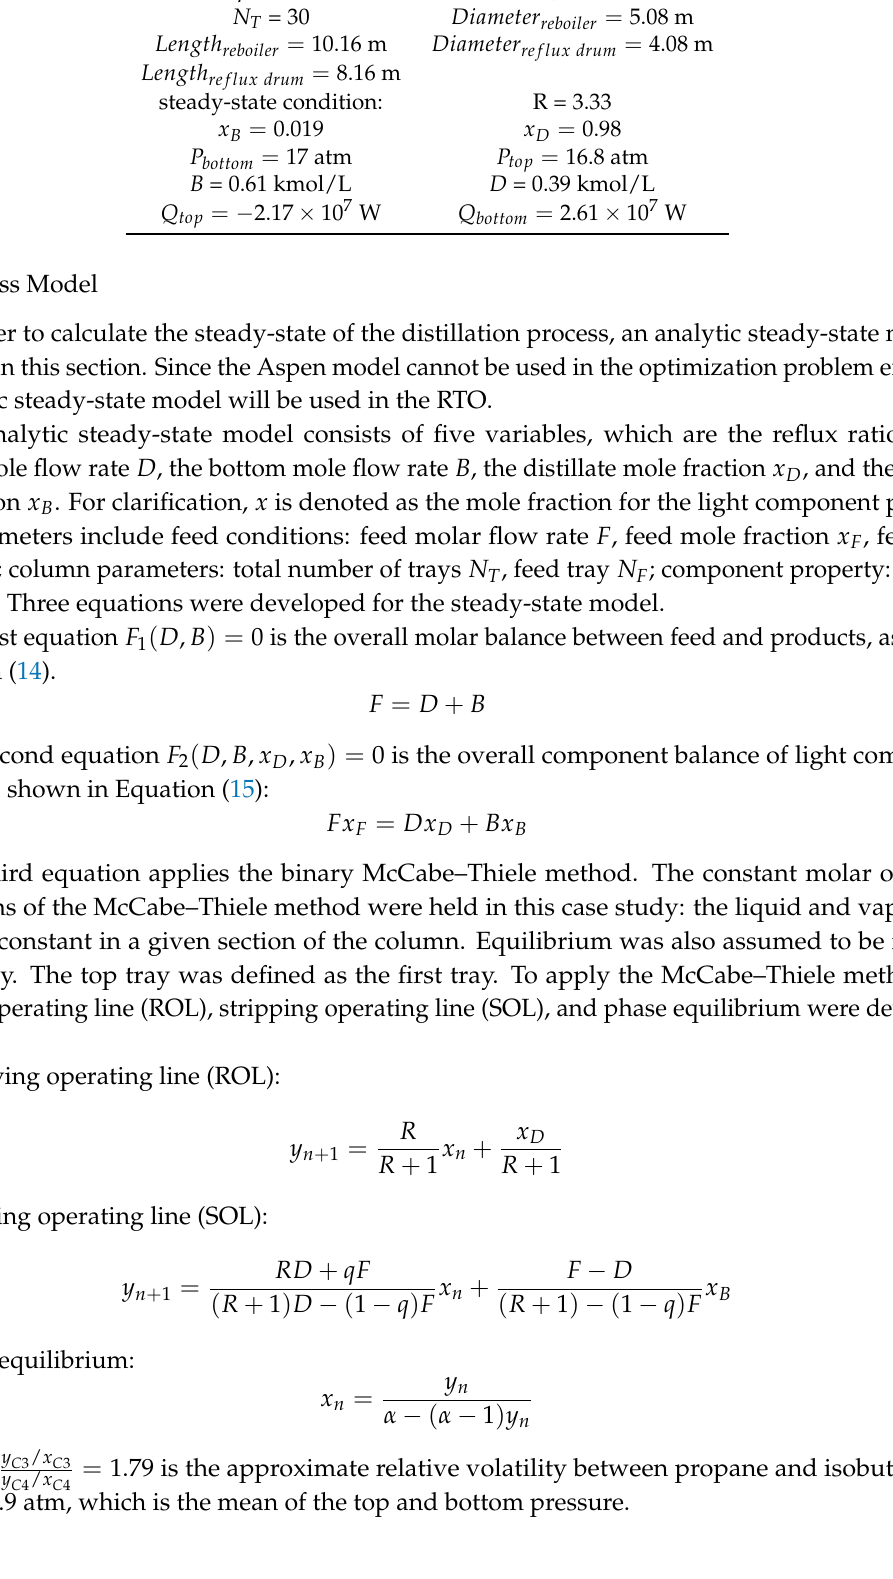
Table 2. Parameter values and steady-state values for the distillation column case study. F = 1 kmol x F = 0.4 T F = 322 K P F = 20 atm